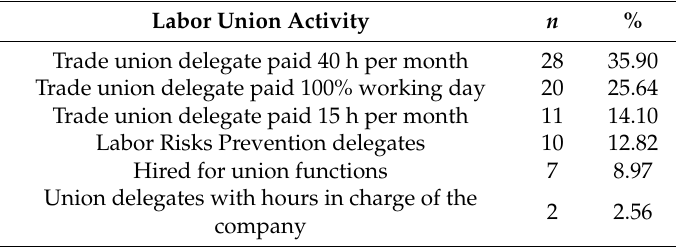
Table 1. Participants’ Union activities and professional